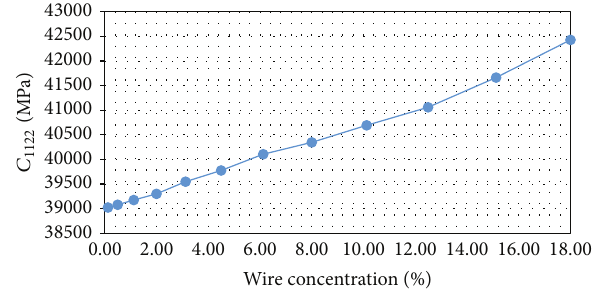
(0) 𝐶 1122 for reinforced plexiglas